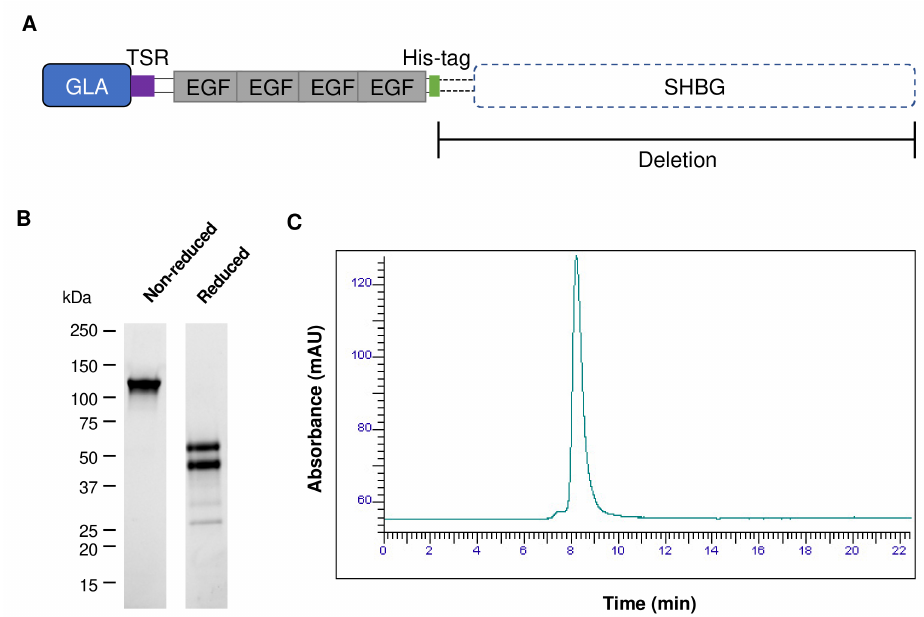
Figure 2. Design and production of the recombinant GlaS protein. ( A ) The GlaS protein was designed from a coagulation factor, Protein S, which consists of a vitamin K-dependent carboxylation/gamma- carboxyglutamic acid (GLA) domain, a thrombin-sensitive region (TSR), four epidermal growth factor (EGF)-like domains, and a sex hormone binding globulin (SHBG)-like domain. The C-terminal SHBG domain was deleted, and a His-tag was attached for protein purification and detection. ( B , C ) The recombinant GlaS protein was analyzed by Western blotting under non-reduced or reduced conditions ( B ) and HPLC-SEC ( C